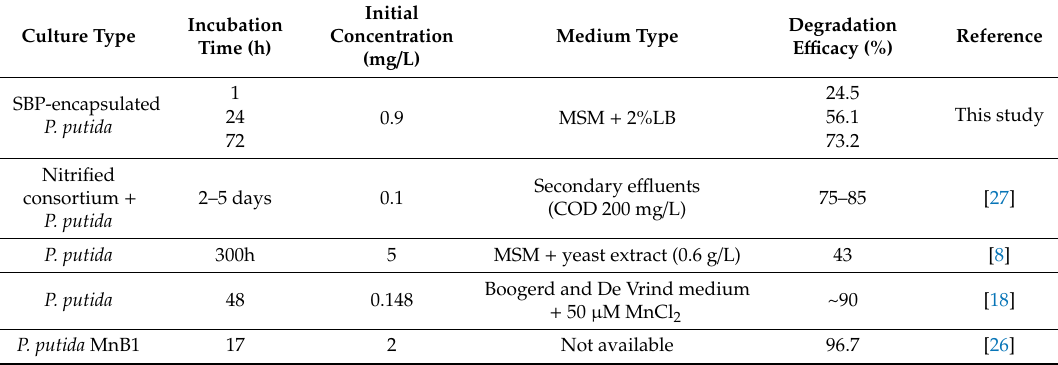
Table 3. Selected literature results for EE2 biodegradation e ffi cacy by co-metabolic activity. Culture